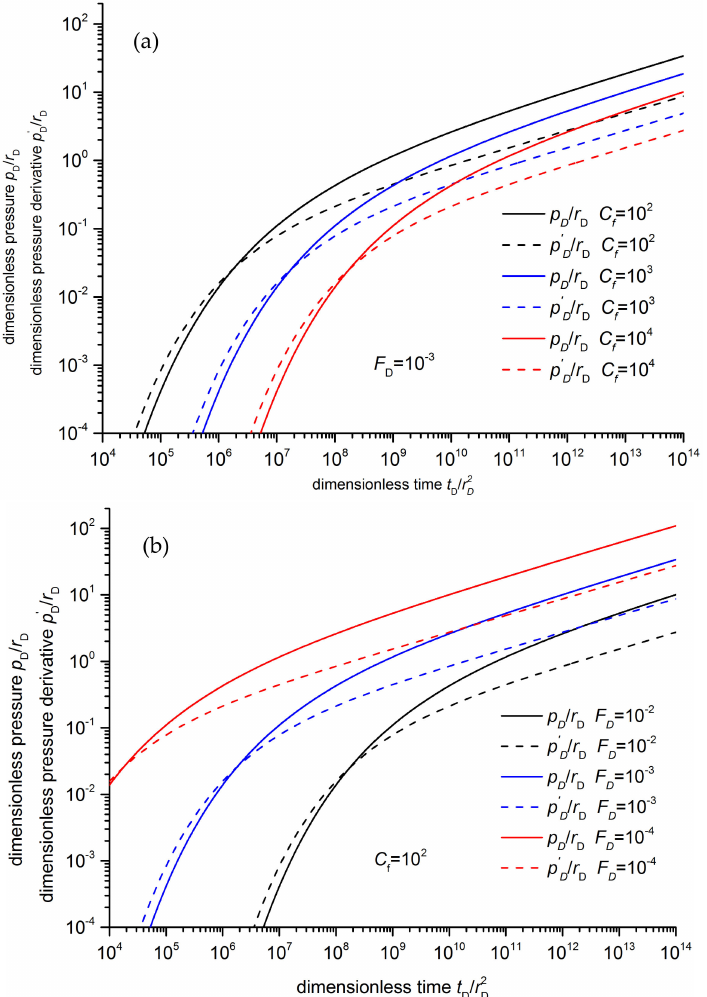
Figure 5. Interference test type-curve for wells connected by a large fracture with crossflow of the reservoir. ( a ) Different C f . ( b ) Different F D